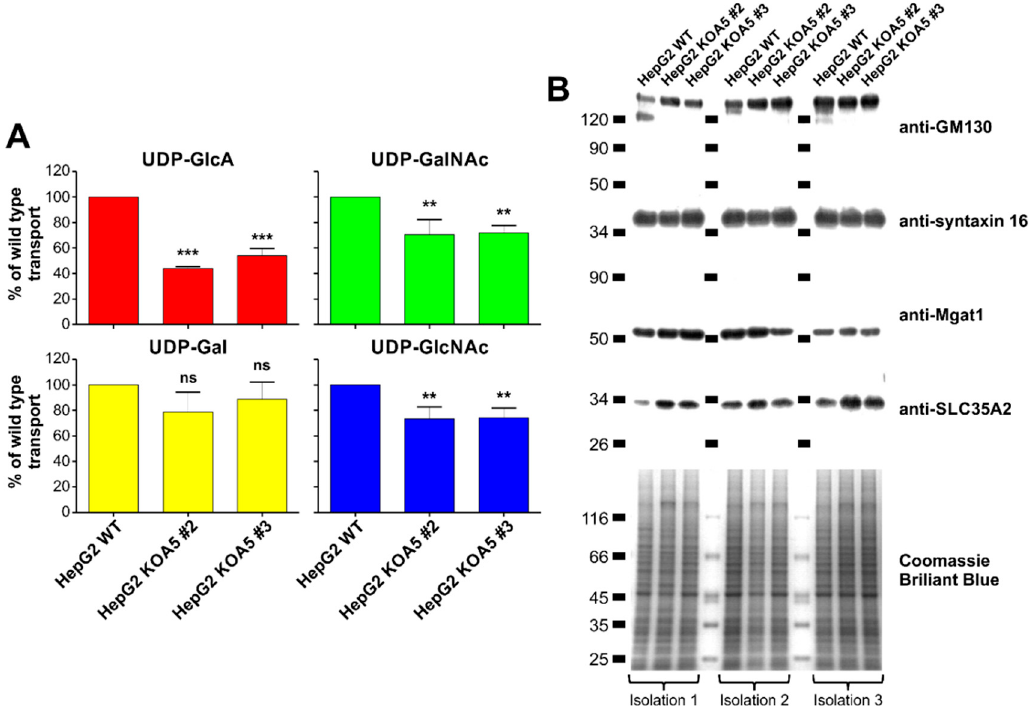
Figure 5. Nucleotide sugar transport assay. ( A ) Uridine diphosphate (UDP)-glucuronic acid (red), UDP- N -acetylgalactosamine (green), UDP-galactose (yellow), and UDP- N -acetylglucosamine (blue)